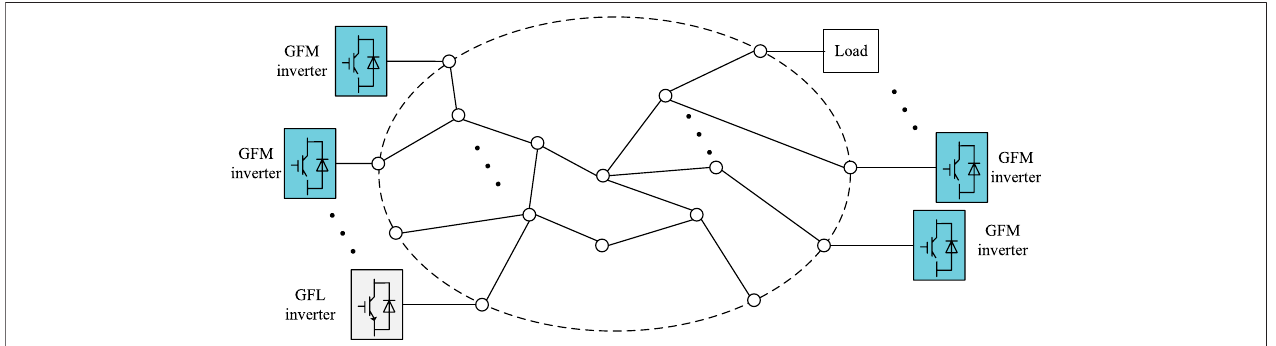
FIGURE 1 | Diagram of the GFM inverter-based power system.